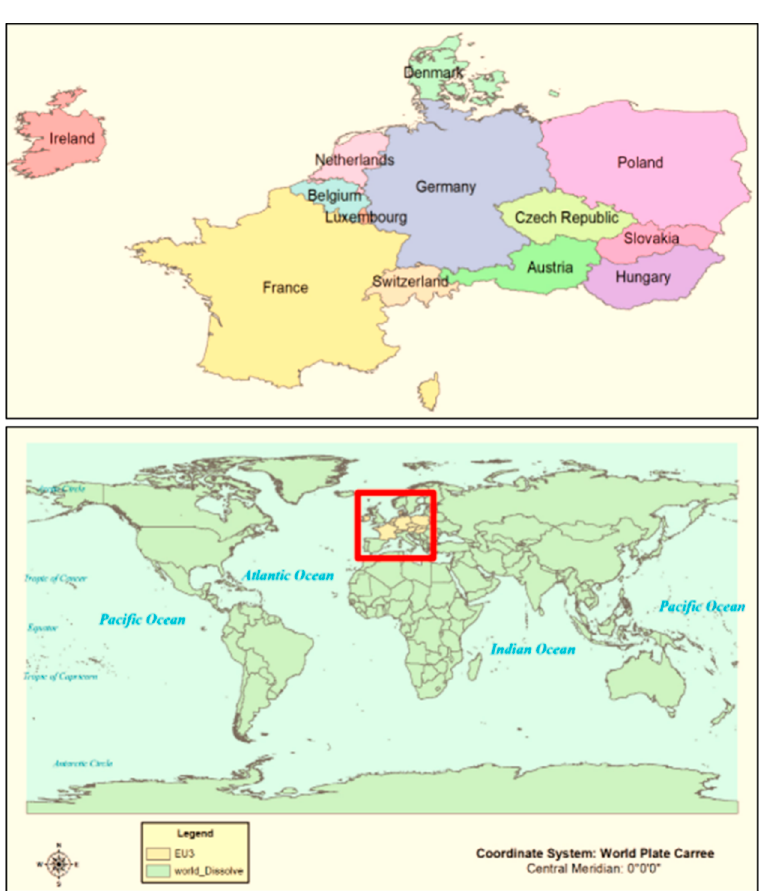
Figure A1. Selected Countries for Study in Europe